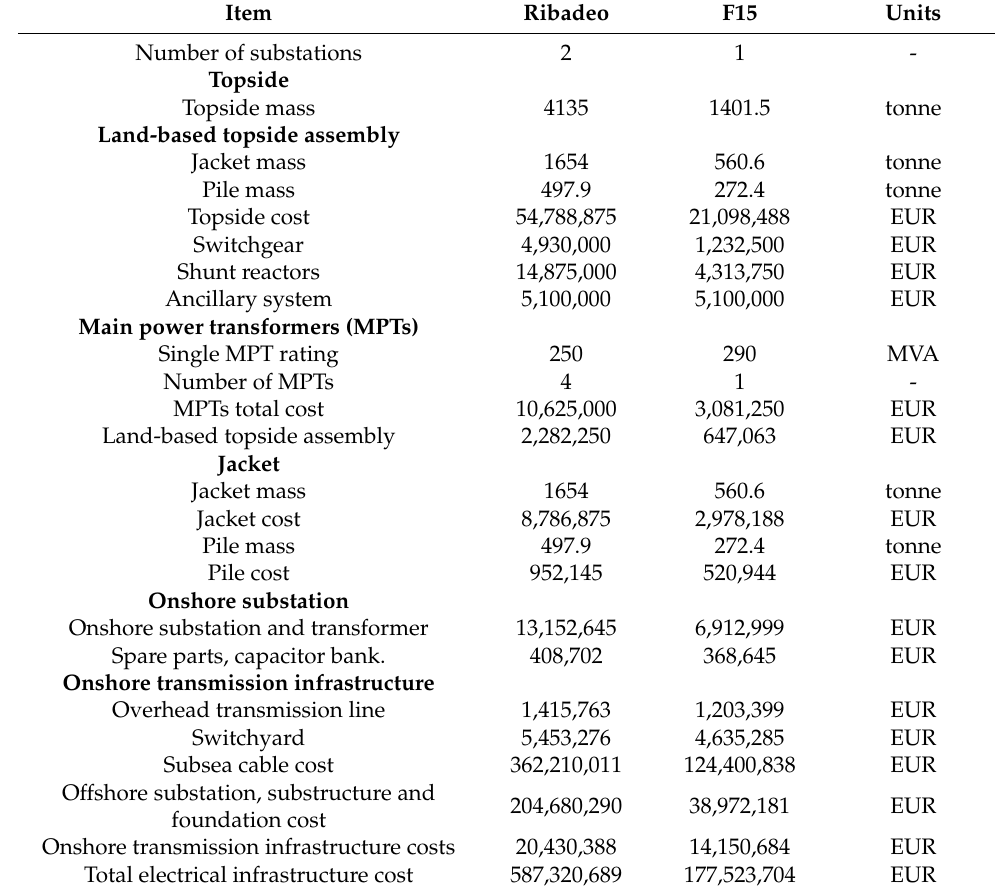
Table 5. Offshore and onshore